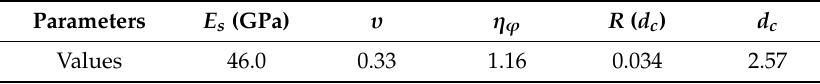
Figure 13. Model results compared to experimental responses of Shandong sandstone (Test data collected from [52]). Table 5. Model’s parameters for Shandong